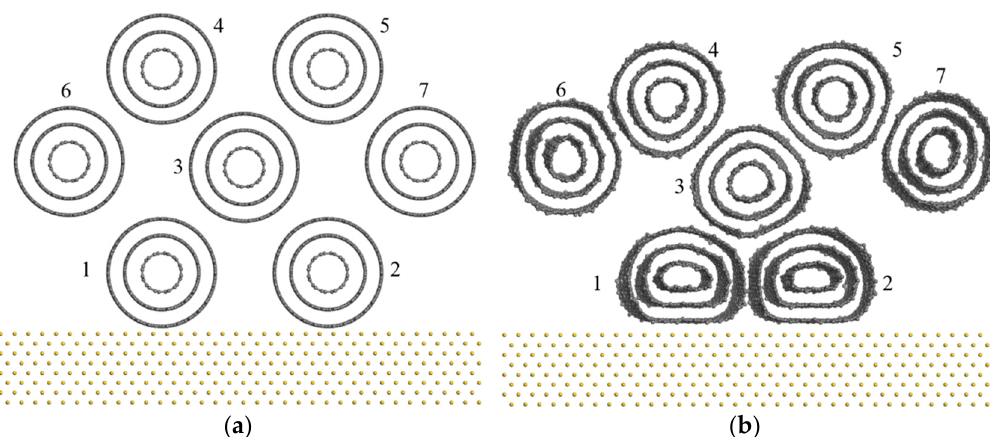
Figure 11. Molecular dynamics simulation of the contact behavior between MWCNT bundles and gold slab: ( a ) initial MWCNT bundle; ( b ) radially deformed MWCNT bundle.